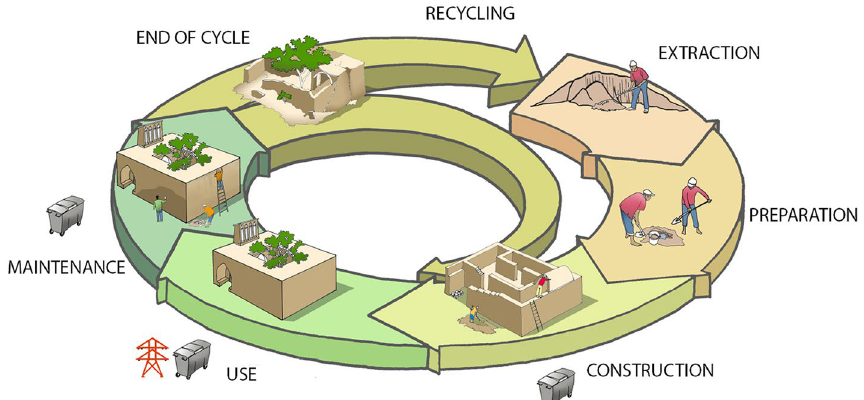
Fig. 5 Life cycle of earthen buildings, from earth to earth, with limited energy waste and limited waste production (Source: the